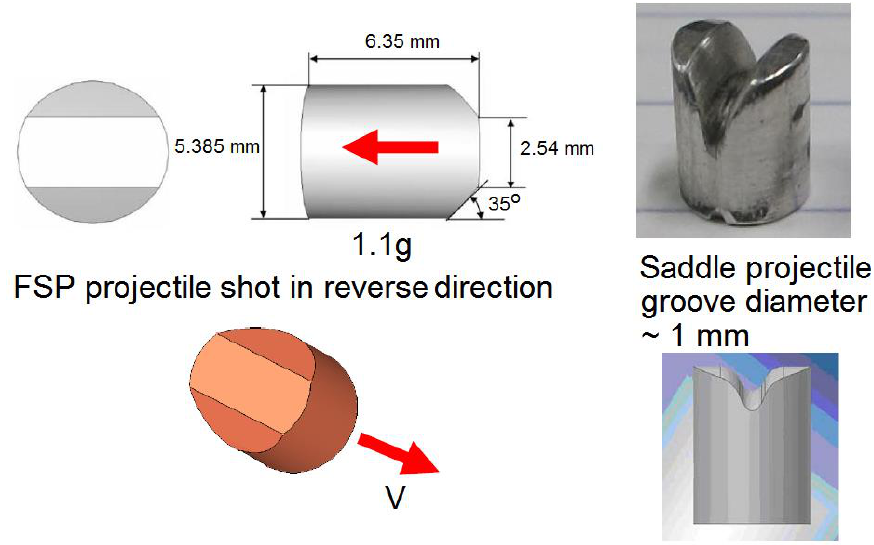
Figure 3. Projectiles used in the yarn shooting experiments.